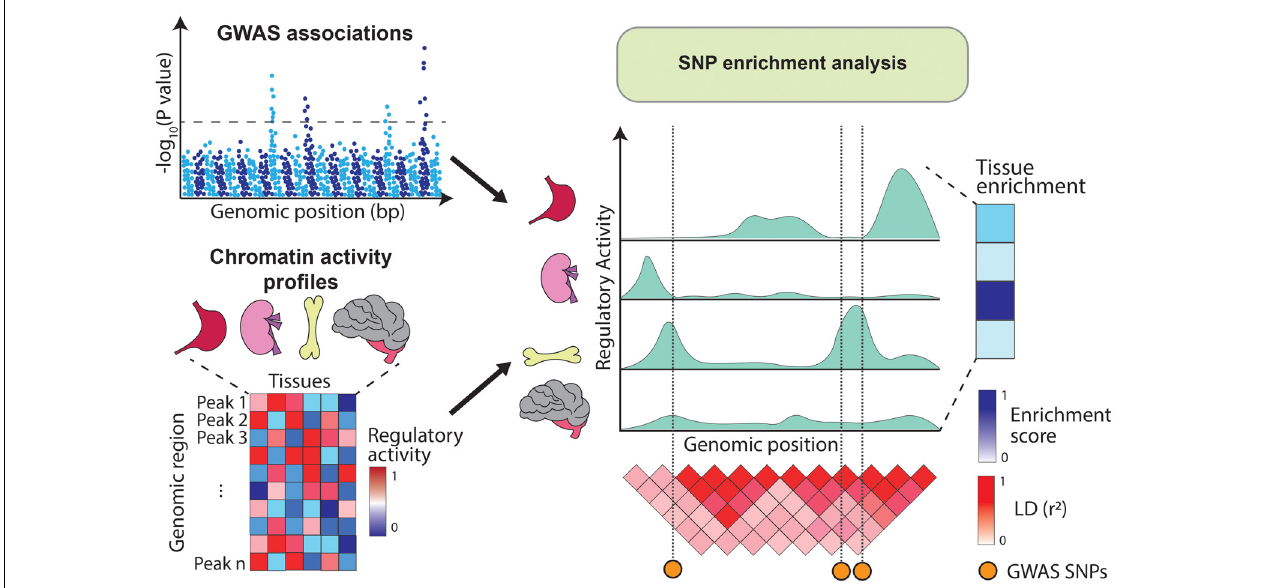
FIGURE 2 | Overview of SNP enrichment analysis using chromatin annotations. SNP enrichment analysis integrates association signals from GWAS (Manhattan plot on the top left) with functional genomics data such as chromatin annotations (heatmap on the bottom left). GWAS SNPs are overlapped with regulatory elements (right panel) and if in a given tissue the overlap occurs more frequently than expected by chance, the tissue is assigned a high enrichment